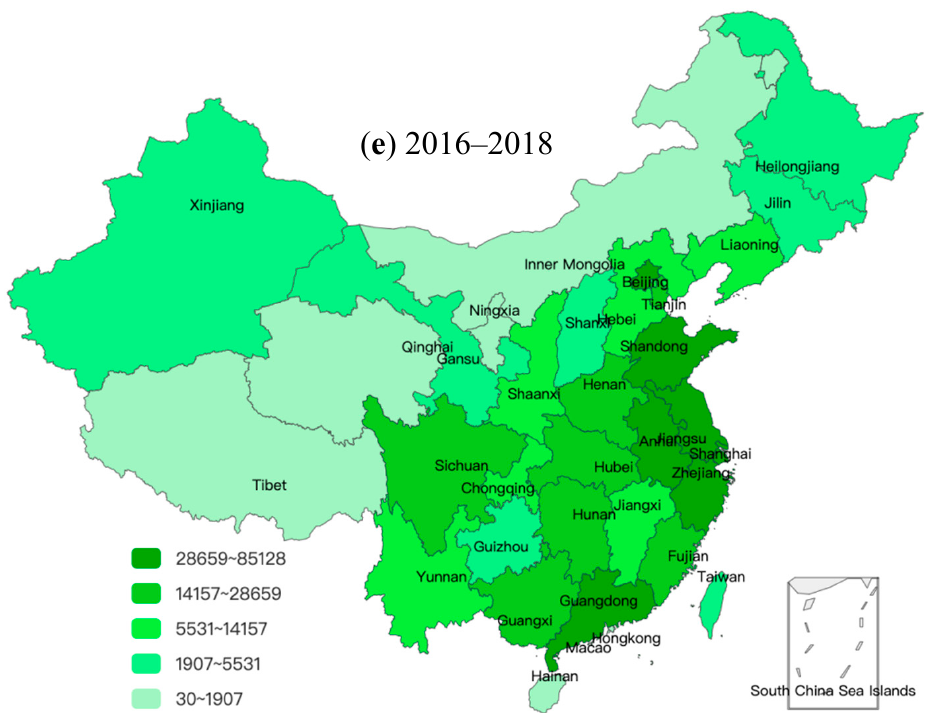
Figure 6. Spatial distribution of green invention patent applications in different periods. ( a ): the first stage (1985–1995). ( b ): the second stage (1996–2005). ( c ): the third stage (2006–2010). ( d ): the fourth stage (2011–2015). ( e ): the fifth stage (2016–2018).